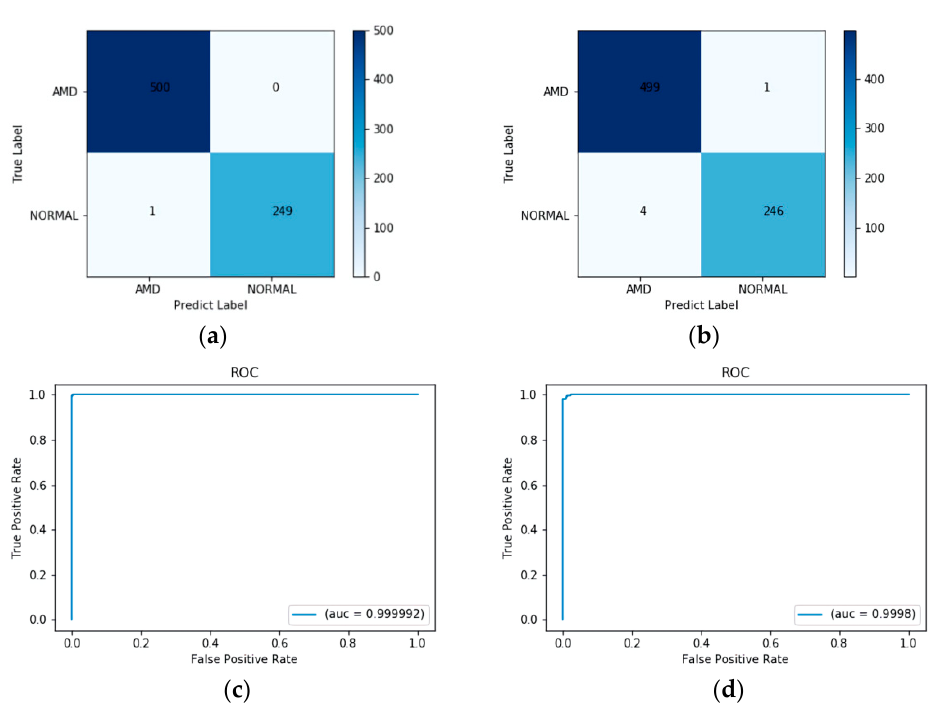
Figure 6. ( a ) Confusion matrix of the proposed method on the UCSD test set. ( b ) Confusion matrix of ResNet-50 on the UCSD test set. ( c ) ROC curve of the proposed method on the UCSD test set. ( d ) ROC curve of ResNet-50 on the UCSD test set.